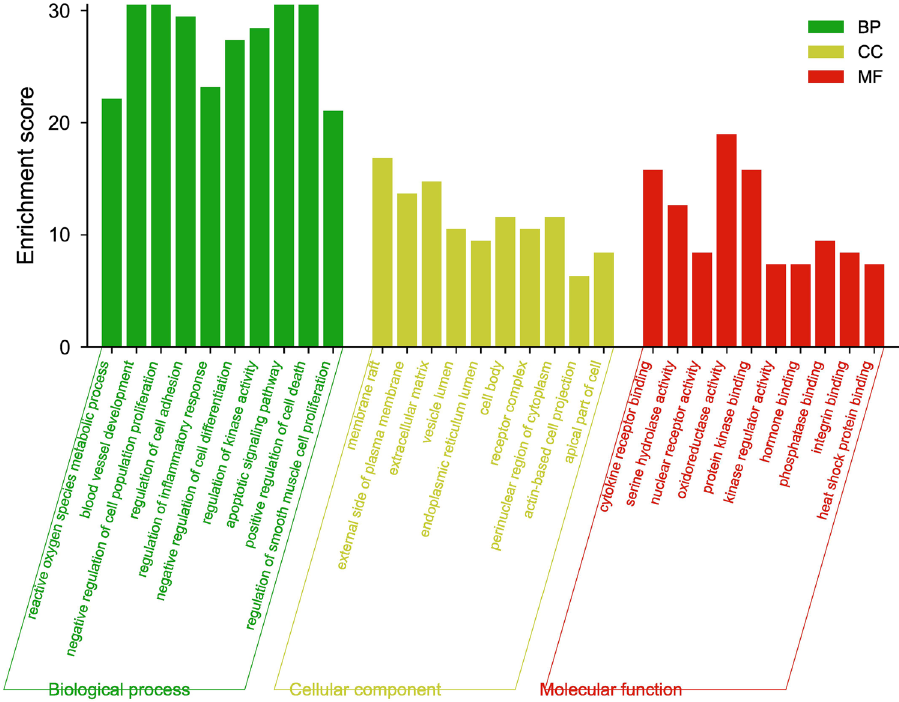
Figure 4. GO functional analysis of quercetin targets relevant to T2DM and AD treatment.